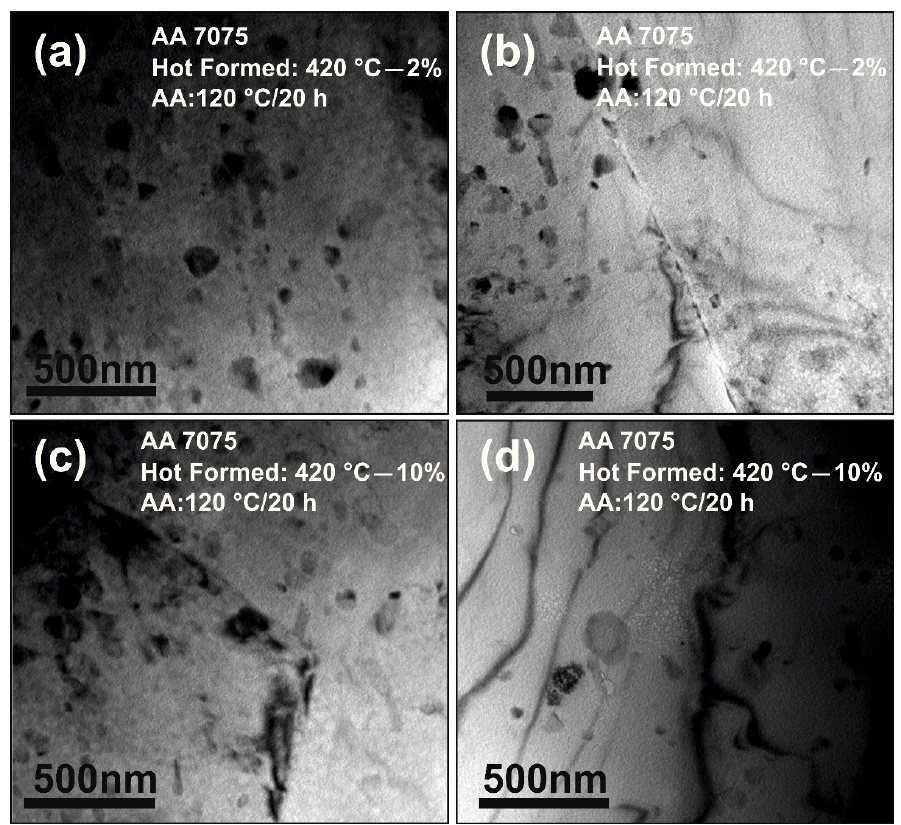
Figure 6. TEM micrographs of the at 420 °C-formed materials of ( a , b ) 2% and ( c , d ) 10% of defor- mation. All samples were solution-heat-treated at 480 °C for 5 min and were artificially aged at 120 °C for 20 h.